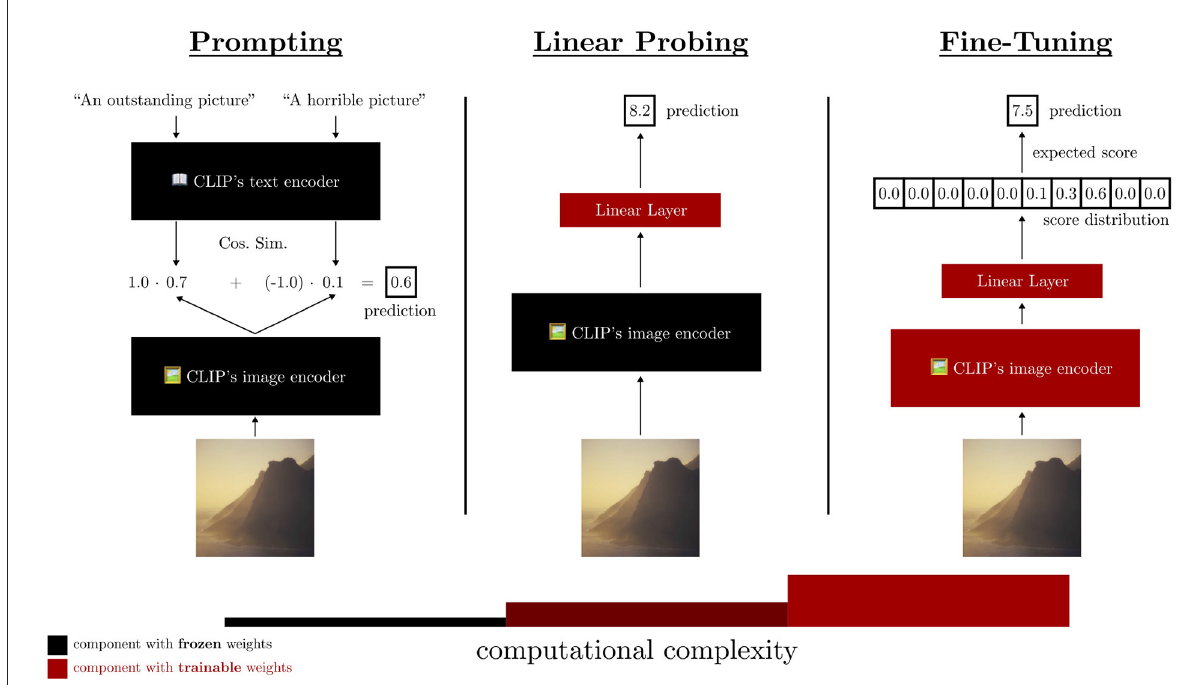
FIGURE1 A schematic overview of our investigation on the suitability of CLIP as a base model for the Image Aesthetic Assessment task. The three steps increase in computational complexity. First, prompting does not modify any parameters. Second, linear probing trains a linear regression on top of the last hidden activations of CLIP’s image encoder. Third, we fine-tune all parameters of the model on the AVA dataset. Our experiments show that CLIP is suitable as a base model for IAA methods, since it extracts features related to image